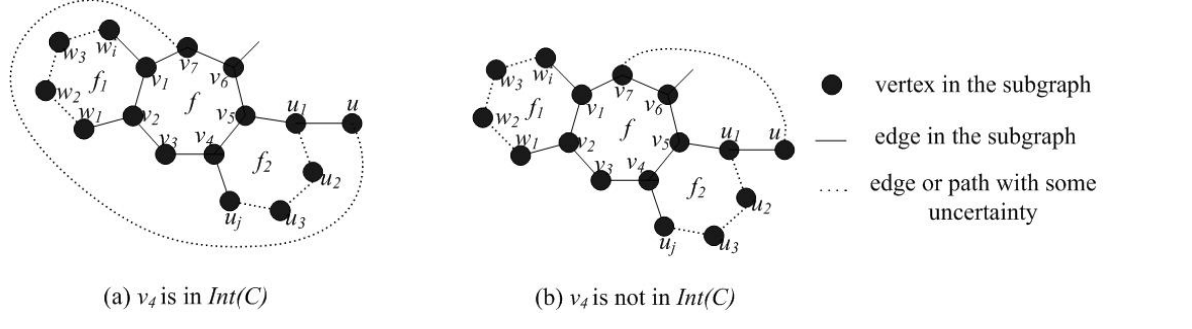
Figure 1. The identification of u and v 7